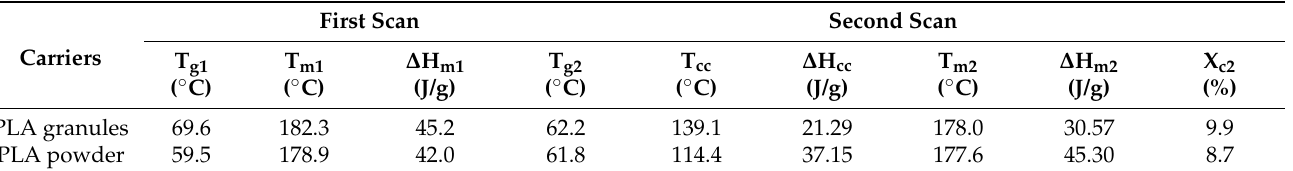
Table 4. Summary of DSC results obtained during two scans of every sample.